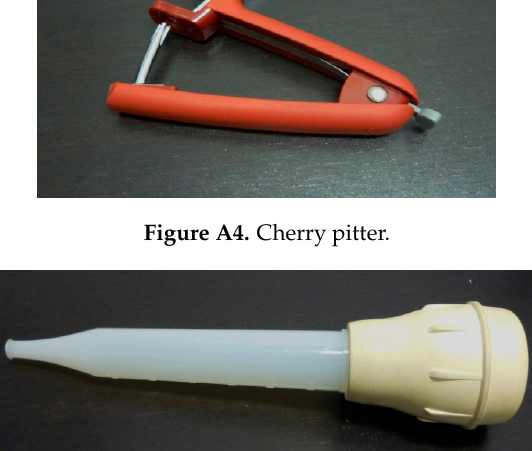
Figure A5. Turkey baster.